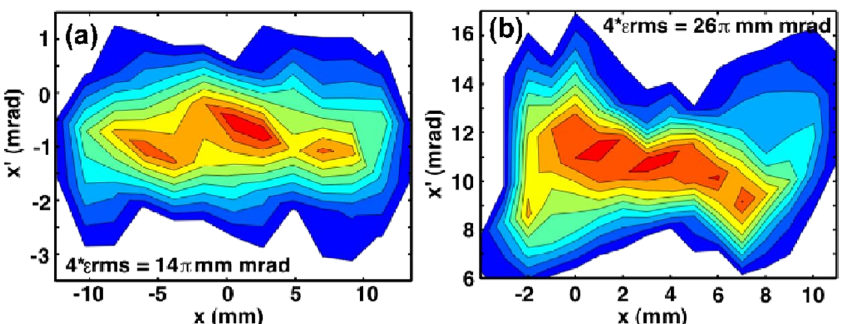
FIG. 4. (Color) Sheared phase space distribution integrated over a 500 ns gate in the middle of the 10 (cid:1) s beam pulse: (a) 15 cm downstream of the exit of the extractor ( z (cid:5) 27 cm ; without solenoid focusing); (b) 40 cm downstream of the exit of four solenoids ( z (cid:5) 290 cm ; note